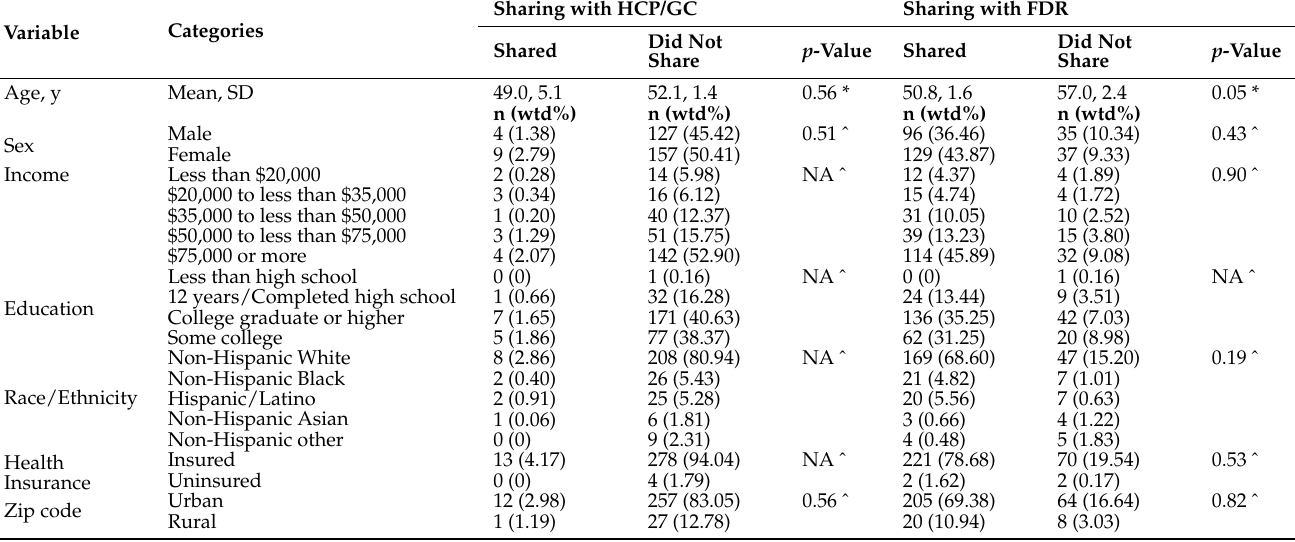
Table 4. Descriptive characteristics of individuals who shared results from ancestry genetic